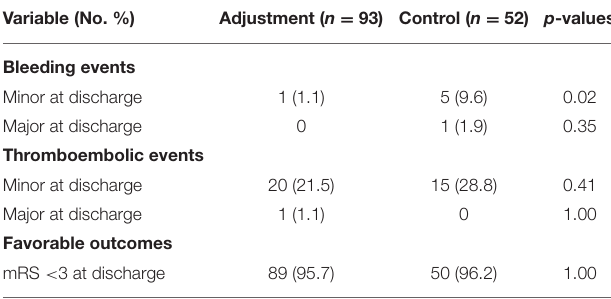
TABLE 3 | Complications and favorable outcomes in patients between adjustment and control groups. Variable (No.